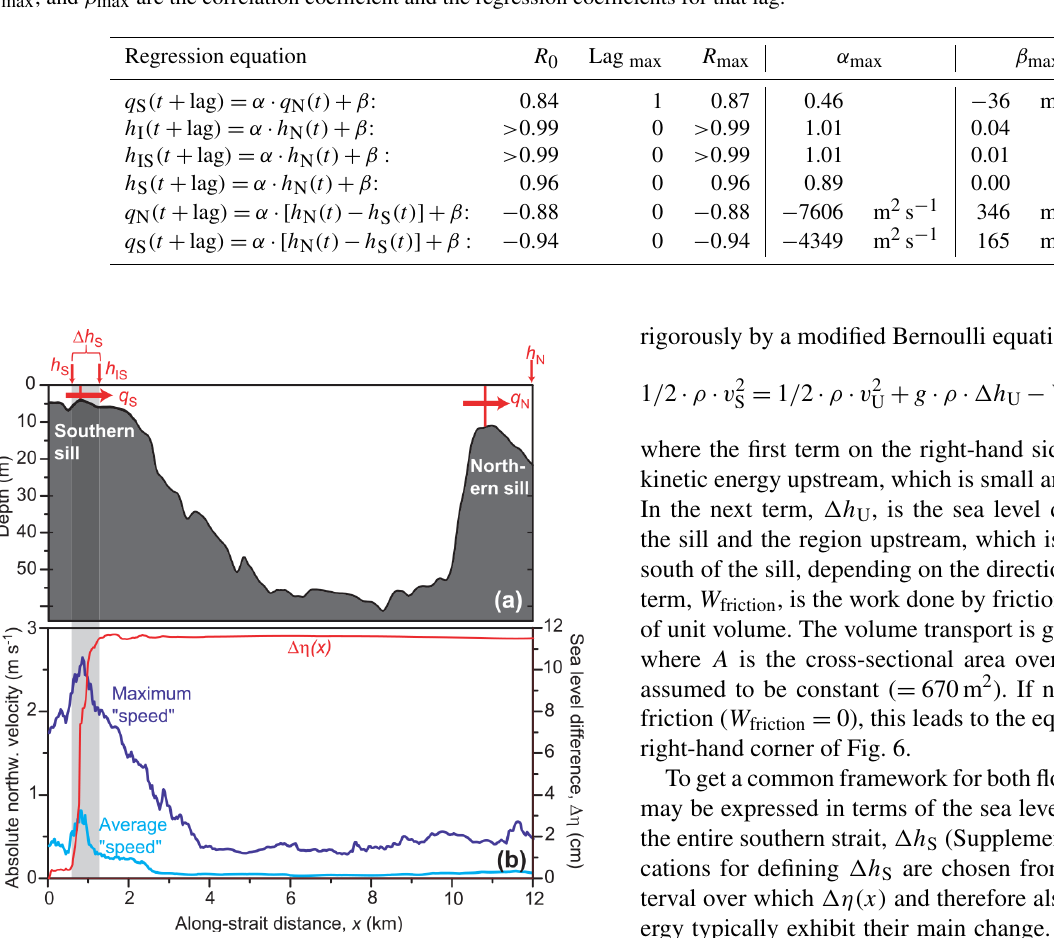
Figure 4. (a) Locations for sampling key time series. (b) The cyan and dark blue curves show the along-strait variation of maximum (dark blue) and (temporally) averaged “speed”, defined as the abso- lute value of the cross-strait-averaged along-strait velocity compo- nent. The red curve shows the standard deviation, (cid:49)η(x) , of the sea level difference between the southernmost part ( x = 0) and a given location, x